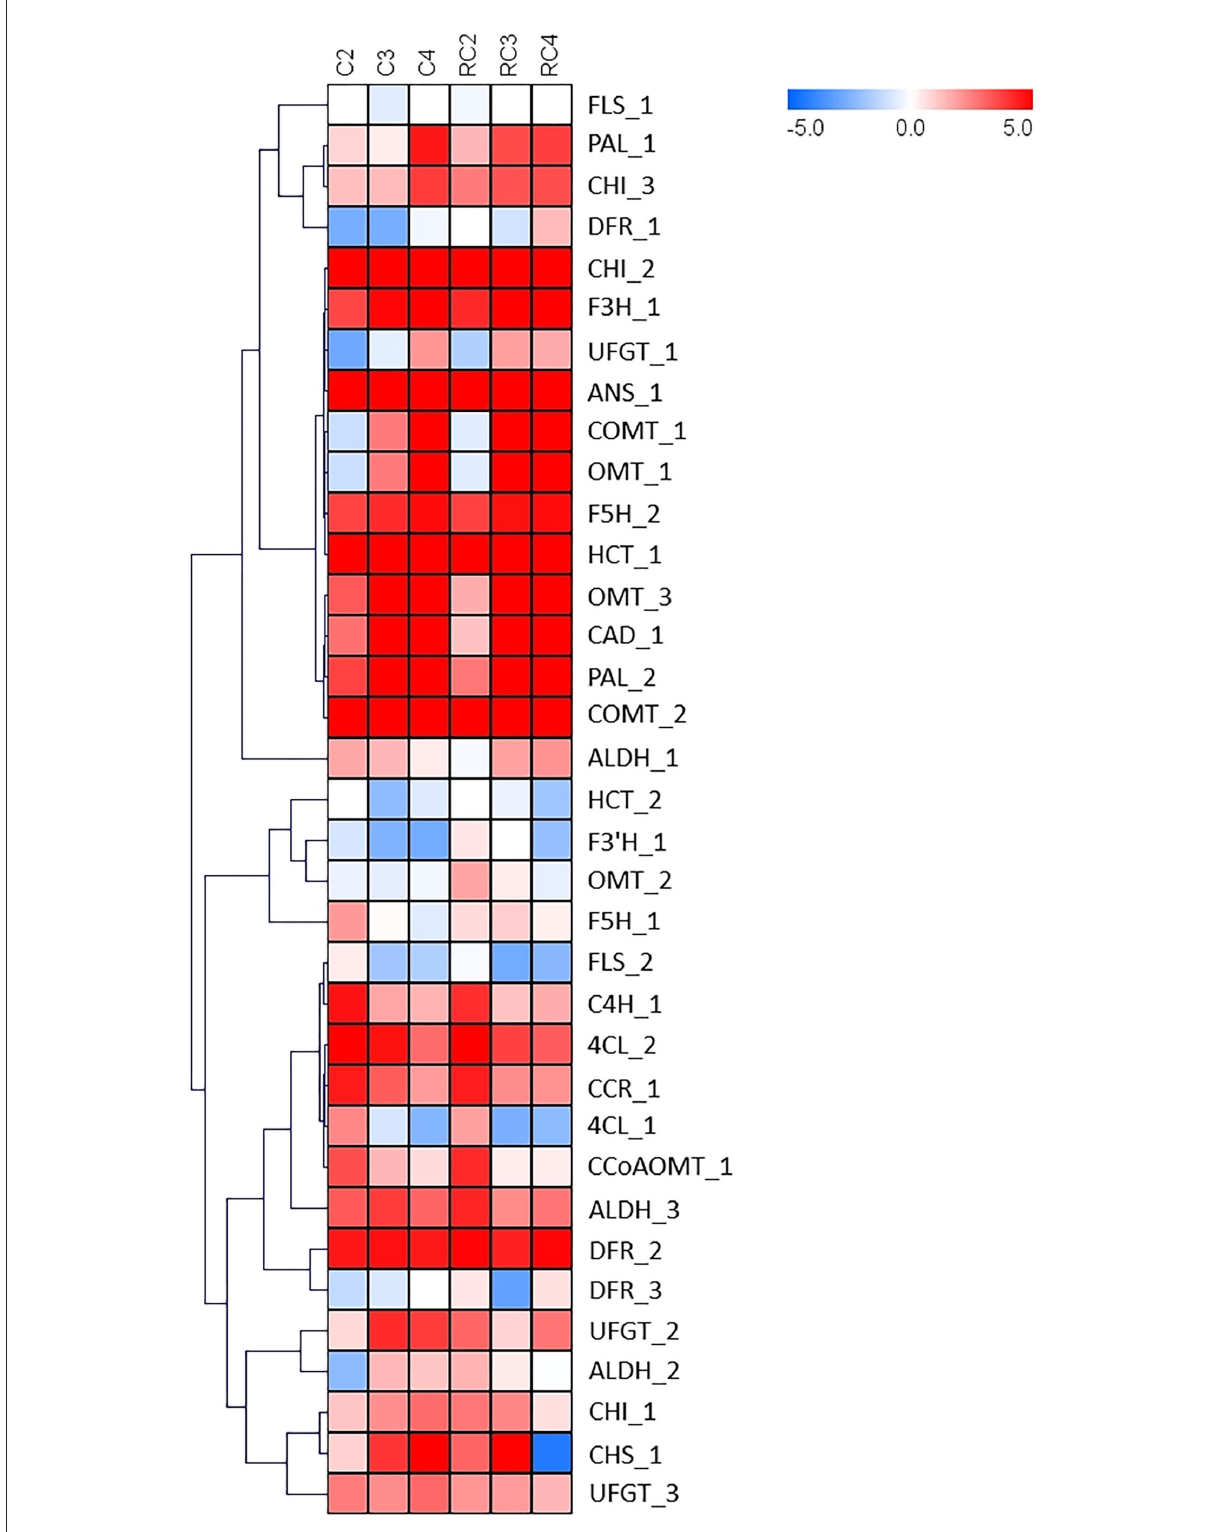
FIGURE8 HeatMap for genes involved in the synthesis of flavonoids. Log2 is calculated to the FPKM value for each gene to delimit extreme values and used to scale expression. To perform hierarchical clustering for fruit developmental stage and tissue type (receptacle and receptacle without achene), we selected the Pearson Correlation distance metric and Average linkage clustering. Levels of decreased expression are shown in blue and increased expression is shown in